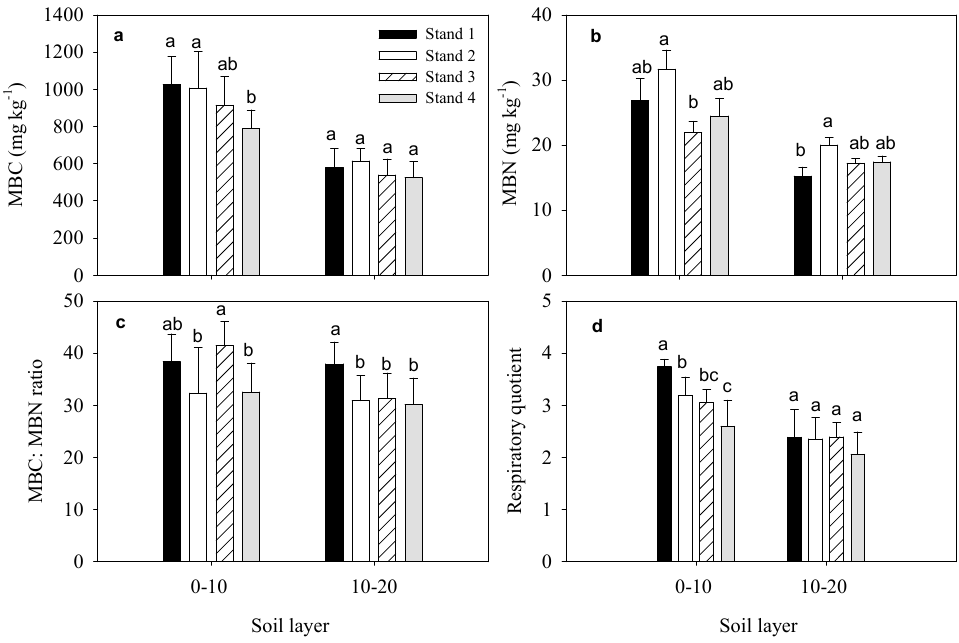
Figure 4. Soil microbial biomass C and N, and the respiratory quotient in four moso bamboo stands. The error bar was the mean value of four samplings (mean±SD, n =4), different lowercase letters indicate significant differences between groups ( p ≤ 0.05). a–d, is the concentration of soil microbial biomass carbon (MBC), soil microbial biomass nitrogen (MBN), the ratio of soil microbial biomass carbon to soil microbial biomass nitrogen, respiratory quotient in soil 0–10 cm and 10–20 cm.